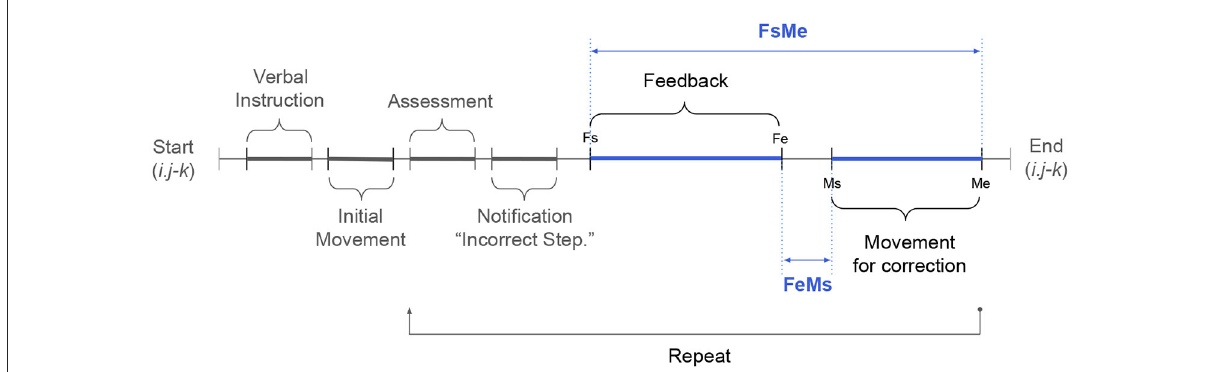
FIGURE4 A timeline showing the sequence of events in the feedback system described in Figure